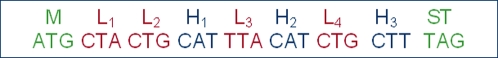
Example of shuffling procedure.The procedure to get the maximal entropy distribution (MED) involves a set of randomized iterations. The triplets of nucleotides coding for each amino acid are permuted randomly among themselves. This is an illustrative example of a mock short protein with eight amino acids. The shuffling procedure randomly permutes L1, L2, L3, and L4 and separately permutes H1, H2, and H3. Each iteration produces a new sequence. For this example, there are 12 different combinations for the leucines and three combinations for the histidines resulting in 36 unique sequences. They are weighted in the shuffling procedure so that the MED is attained in the limit of a large number of iterations.